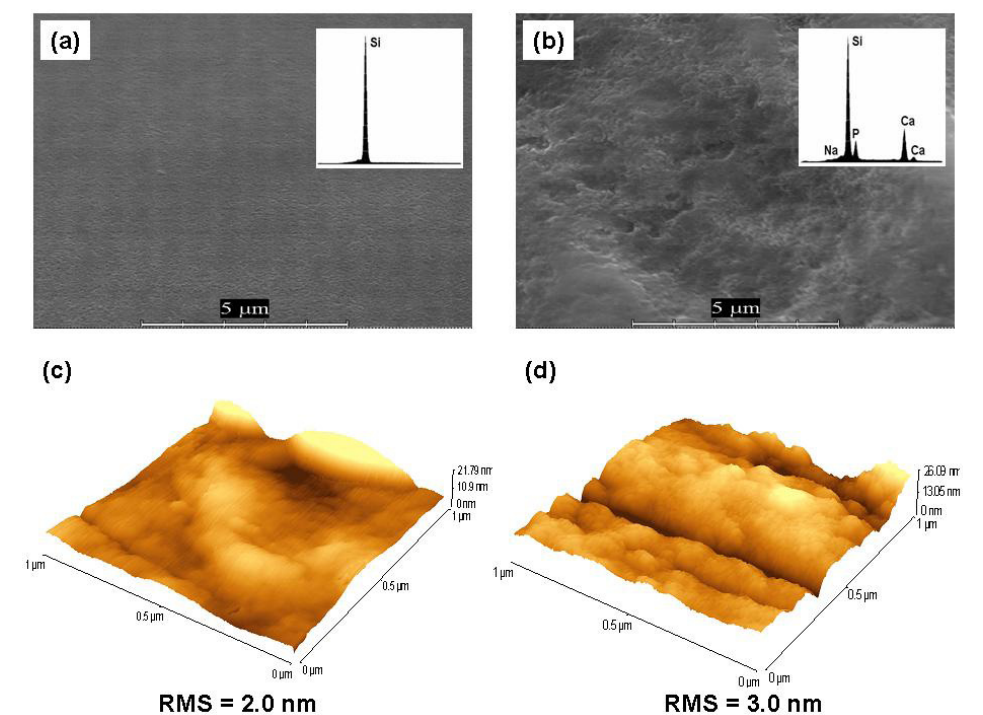
Figure 3. SEM - EPMA surface analysis (a, b) and AFM images (c, d) of glass ceramic samples (a, c – GC0, b, d – GC14) before immersion in SBF.